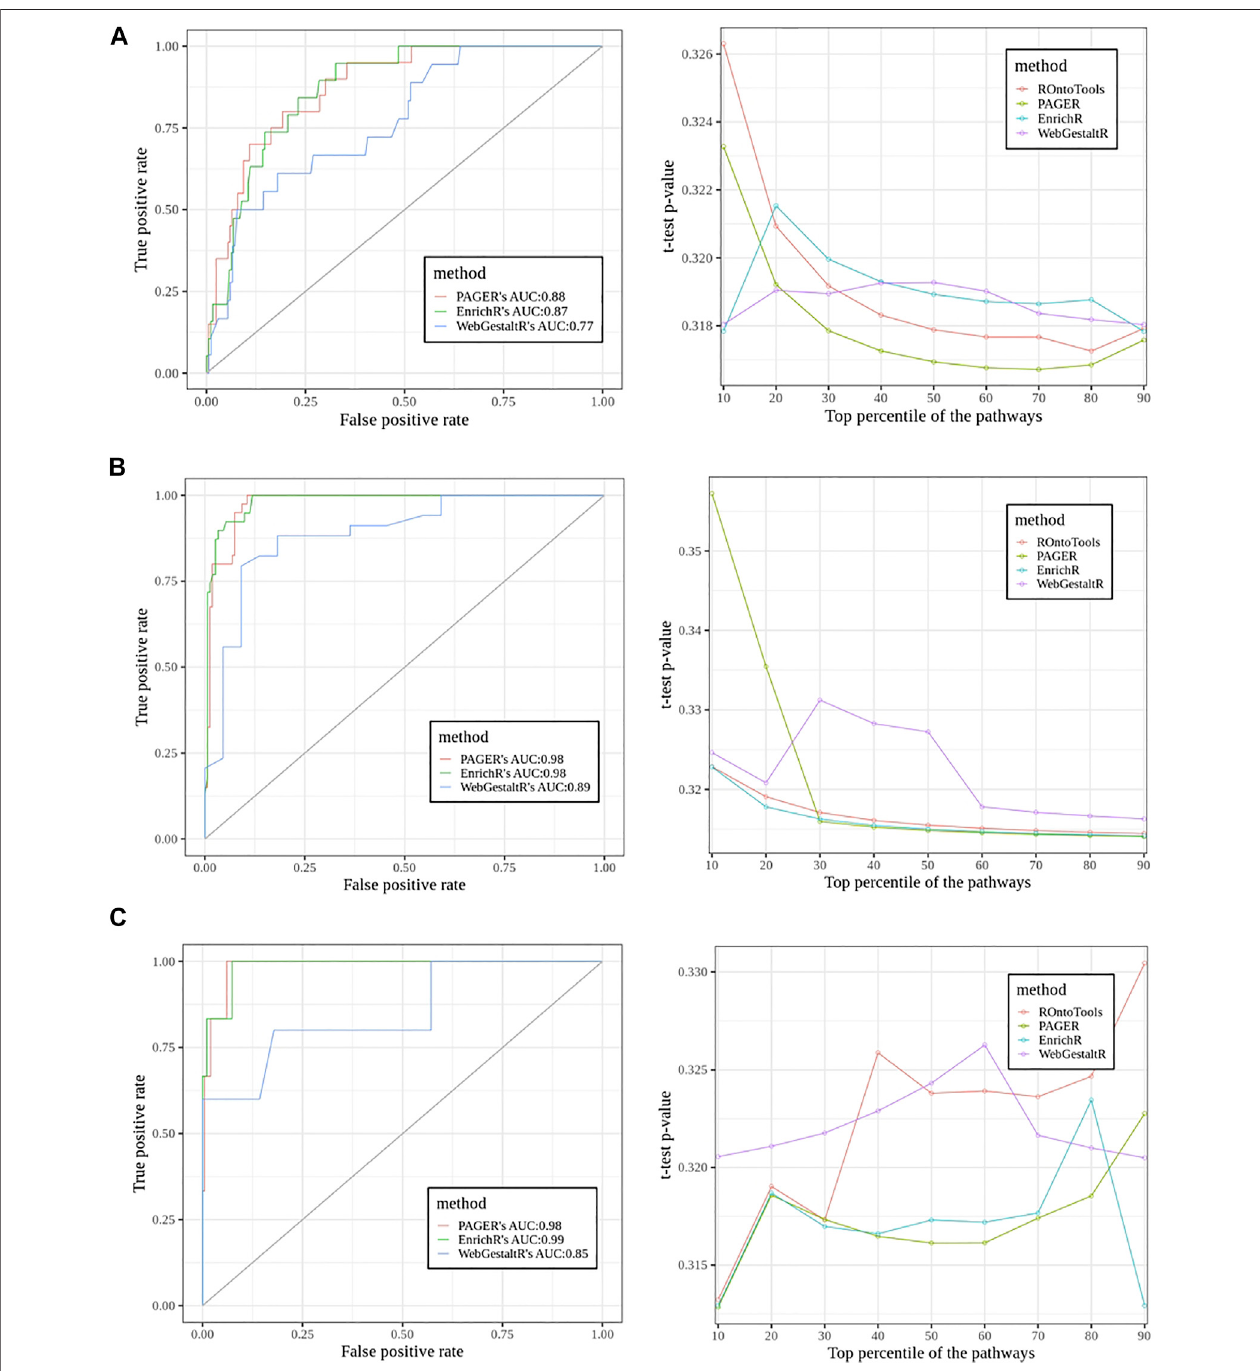
FIGURE 5 | The performance comparisons among PAGER, EnrichrR and WebGestaltR using Receiver Operator Characteristic (ROC) curve and the t-test curve. The pathways ’ adjusted p -values were applied to generate the ROC curves. The PubMed scores were used for the t-test curve. (A) The sclerosis study (E-GEOD- 21942). (B) Thein fl amedcolonicmucosavs.non-in fl amedcolonicmucosainCrohn ’ sdiseasestudy. (C) Thein fl amedcolonicmucosavs.non-in fl amedcolonicmucosa in the ulcerative colitis study.